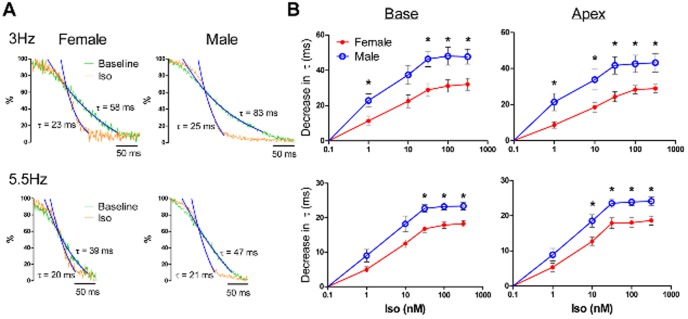
Less Iso-induced decrease of τ in female hearts.A) Relaxation phase of the CaT (peak amplitude to full recovery to diastolic levels) at baseline and during treatment with Iso superimposed to demonstrate the sex differences in the effect of Iso on the CaT decay kinetics at both 3 Hz (top) and 5.5 Hz (bottom) pacing. Single exponential decay functions (blue curves) were fit to the relaxation phase of the CaT, with the time constant of decay (τ) shown for each trace. B) Sex differences in the decrease in τ (versus baseline values) as a function of the dose of Iso (1, 10, 31.6, 100, 316.2 nM) in the LV base (left) and apex (right) of female (n = 5) and male (n = 5) hearts with pacing at 3 (top) and 5.5 Hz (bottom). *p<0.05, female versus male.